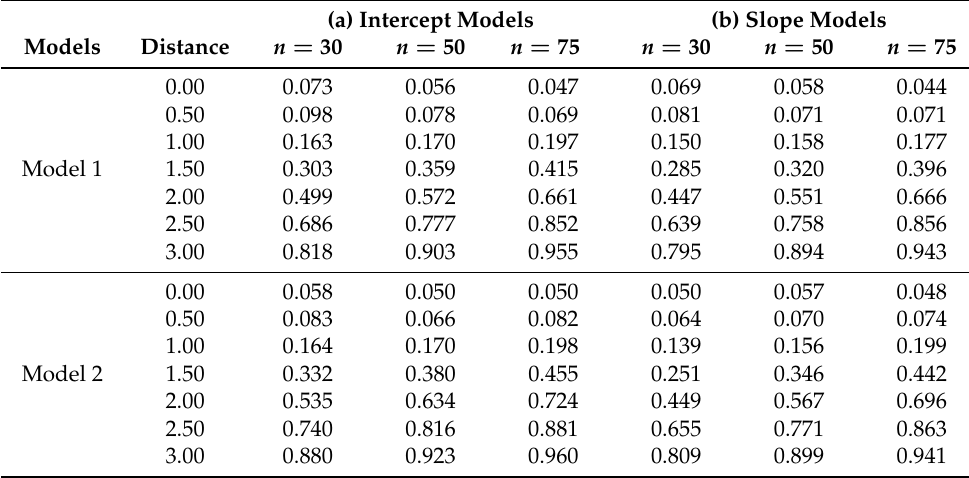
( τ ) for intercept models and slope models with τ = hs